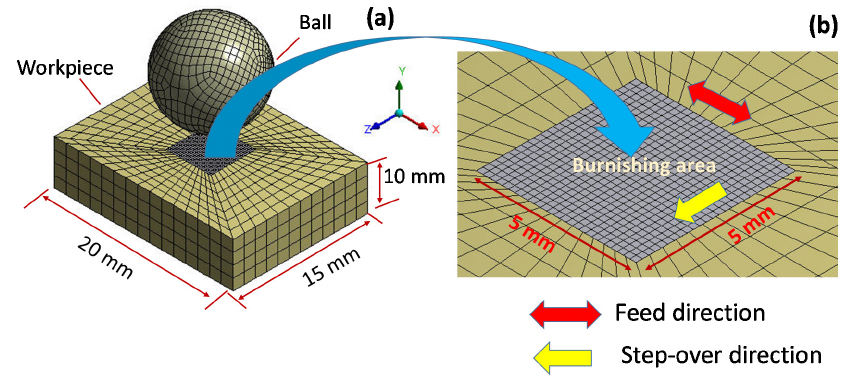
Figure 4. Finite element (FE) model of the burnishing process ( a ) 3D view of model ( b ) close-up of test coupon.